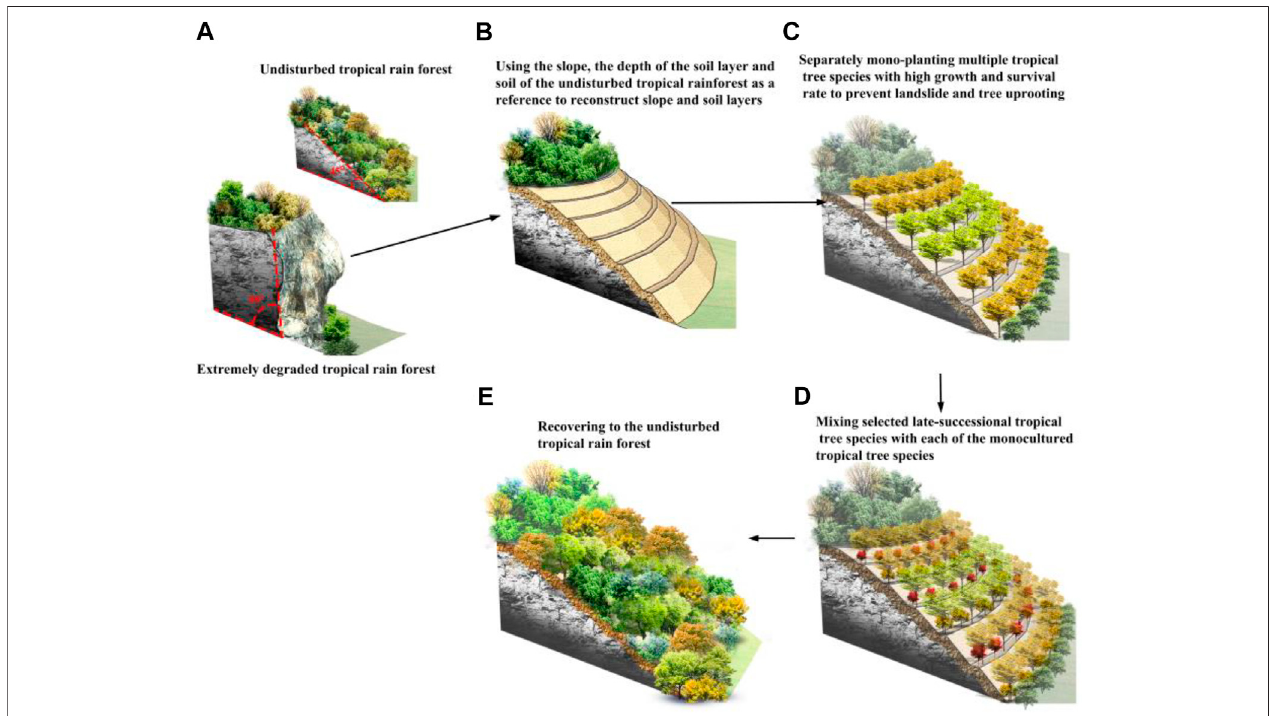
FIGURE 6 | A protocol for successfully performing reforestation to recover extremely degraded tropical rainforest. (A) Extremely degraded tropical rain forest and the adjacent undisturbed old-growth tropical rain forests. (B) using the slope, the deep of soil layers as a reference to reconstructing slope and soil layers,and tore fi llsoilsfrom theundisturbed old-growth tropicalforeststoform plantingareain theextremelydegradedtropicalrain forest; (C) separately mono- planting multiple tropical tree species with high growth rate and survival rate; (D) mixing selected late-successional tropical tree species in the undisturbed tropical rainforest with each of the monocultured tropical tree species; (E) Recovering the extremely degraded tropical rainforest to the undisturbed old-growth tropical rainforest.